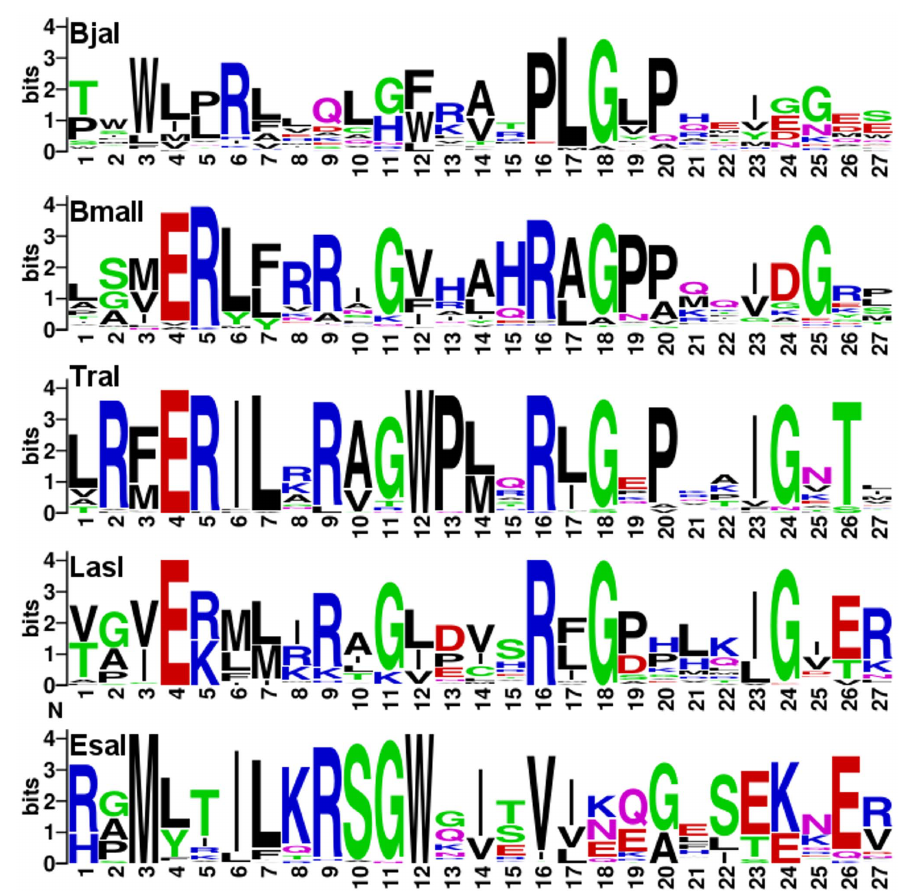
Figure 4. Protein logos of the ACP-binding loop for selected clades of acyl-HSL synthases. The clades are identified by a characterized member. The ACP binding region is based on a previously published analysis and corresponds to amino acid residues 146–173 of LasI and 144–172 of EsaI [19]. Positively charged residues are in blue.